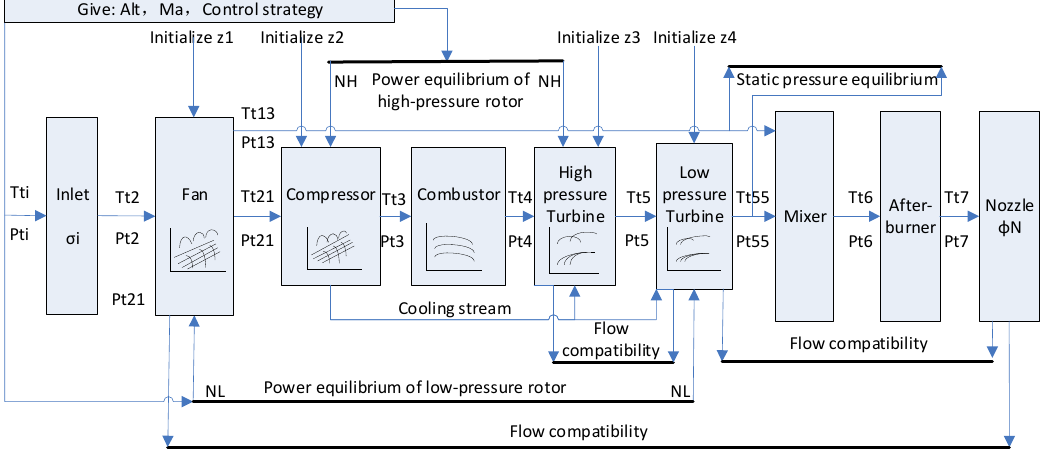
Figure 5. Component-level turbofan engine simulation model.